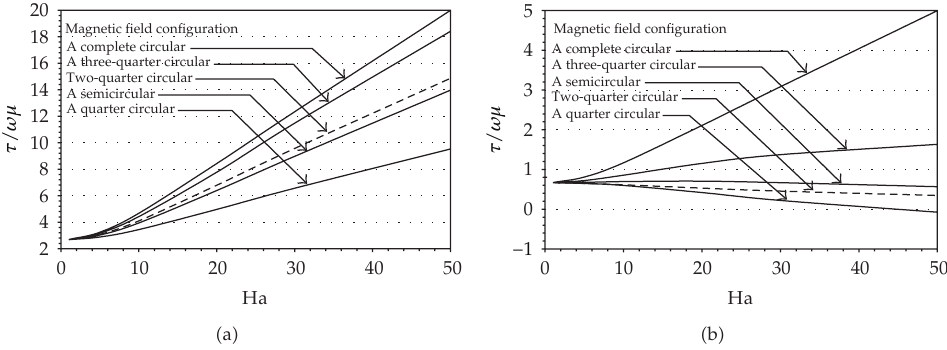
Figure 11: Variation of dimensionless shear stress on cylindrical surface: (cid:2) a (cid:3) inner and (cid:2) b (cid:3) outer.